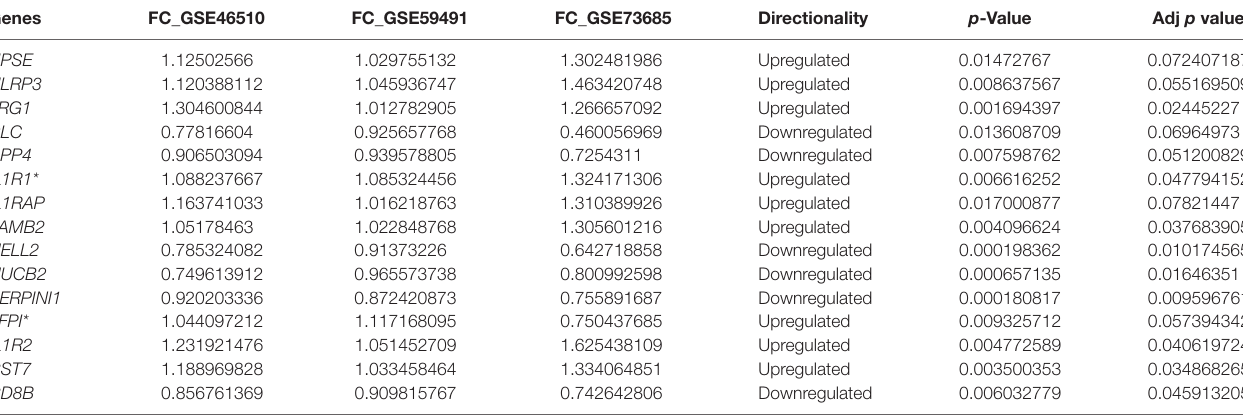
taBle 3 | Secreted proteins from meta-analysis and T2 ad hoc